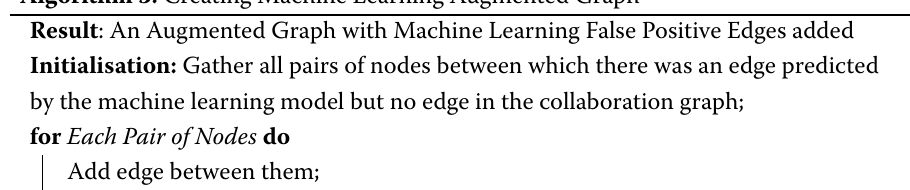
Algorithm 3: Creating Machine Learning Augmented